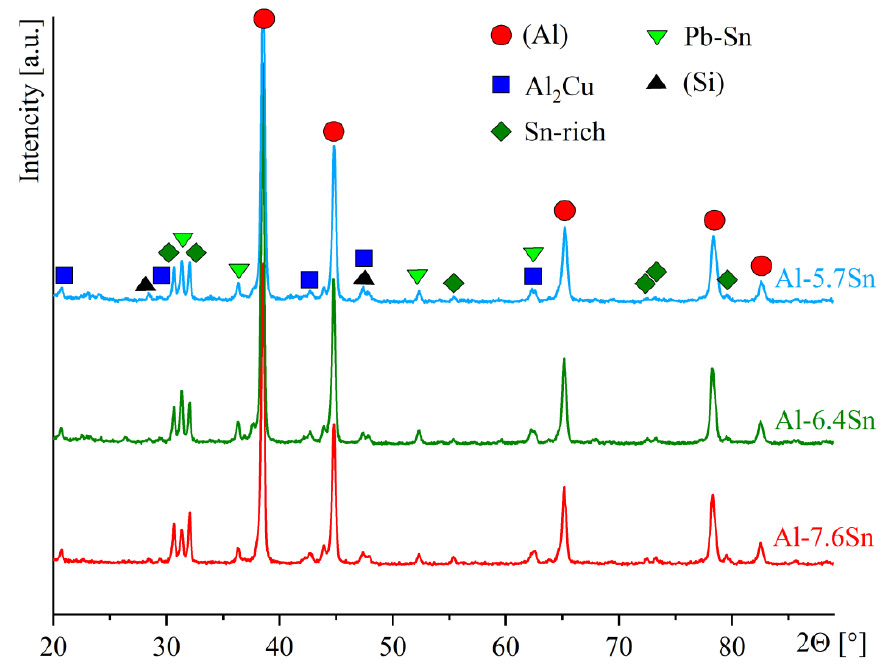
Figure 6. XRD patterns for the investigated alloys.